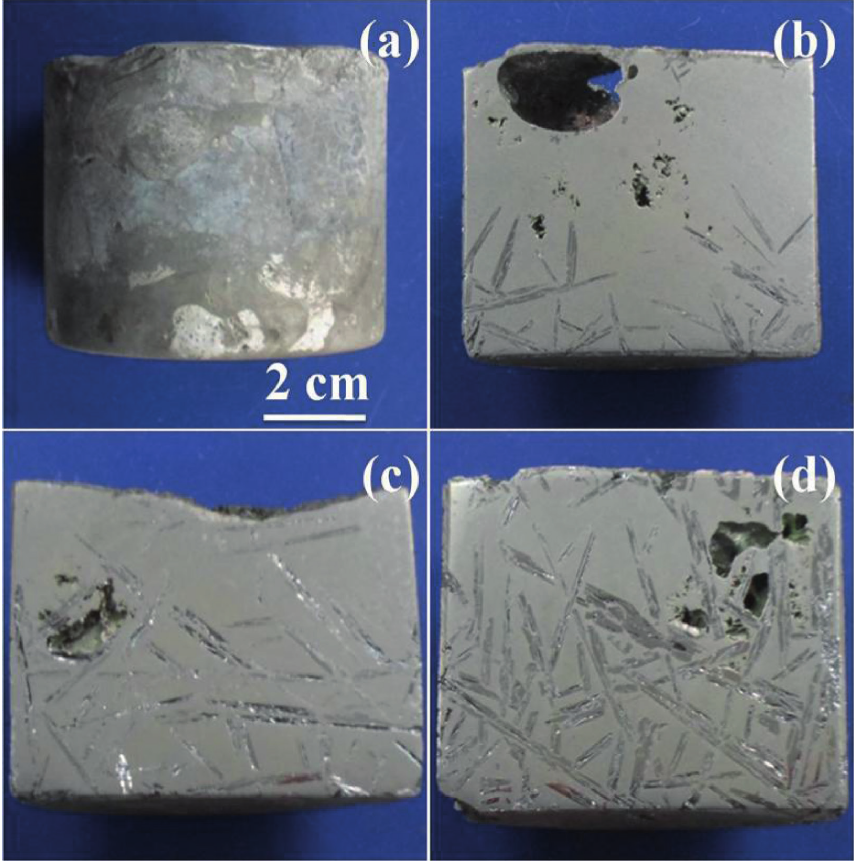
Fig. 3: Macrostructure of the samples: (a) ingot before cutting, (b) cross section of 20% mass Si-Al alloy cooled at 0.27 mK/s, (c) cross section of 30% mass Si-Al alloy cooled at 0.55 mK/s, (d) cross section of 40% mass Si-Al alloy cooled at 0.81